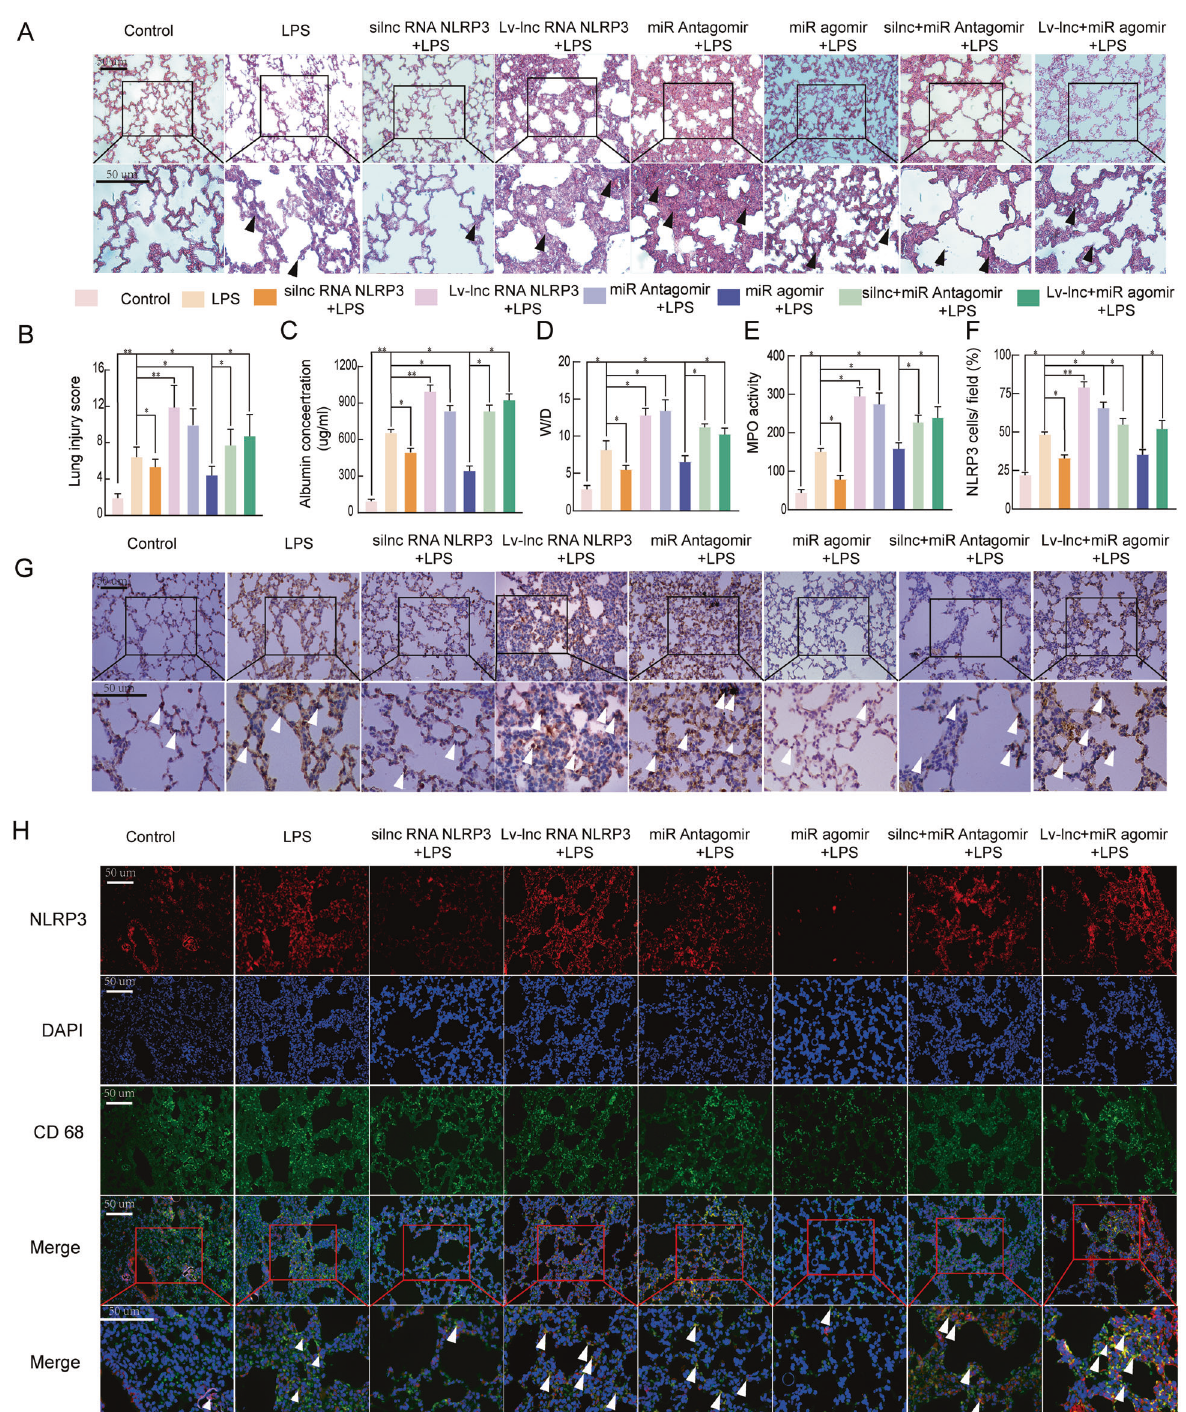
Fig. 7 LncRNA NLRP3/miR-138-5p/NLRP3 functions via the ceRNET during the NLRP3-triggered in fl ammatory response in vivo. Rat lungs were injected with PBS in the control group and LPS-treated rats were further treated with si-r-lncRNA NLRP3, Lv-lncRNA NLRP3, agomiR-138- 5p, antagomiR-138-5p, Lv-lncRNA NLRP3 + agomiR-138-5p, and si-r-lncRNA NLRP3 + antagomiR-138-5p. A Lung tissue samples were collected 6 h after establishing LPS-induced ALI to analyse the histopathological changes (×200, ×400). The black arrow indicates neutrophil in fi ltration, pulmonary oedema, alveolar wall thickening, and alveolar haemorrhage. B The lung injury score was determined via H&E staining, a representative histological analysis ( n = 6 animals per group). C ELISA was used to measure the BALF albumin content. D Detection of the lung W/D ratio in rats. E MPO activity in the lung tissues of rats. F , G Immunohistochemical detection of the NLRP3 contents in rat lung tissues (×200, ×400). H The in fl ammatory response in NR8383 AM cells was suppressed by si-r-lncRNA NLRP3 and miR-138-5p mimics alone or in combination, as shown by the decreased number of cells colabeled with CD68 (green) and NLRP3 (red). LncRNA NLRP3 overexpression, miR- 138-5p inhibition, and NLRP3 augmented the in fl ammatory response in LPS-induced ALI with more NLRP3 and CD68 anchored in the plasma membrane of the AM cells. The data are presented as mean ± SE ( n = 6). * P < 0.05; ** P < 0.01; *** P < 0.001; NS, no statistically signi fi cant difference. Cell Death and Disease (2021)